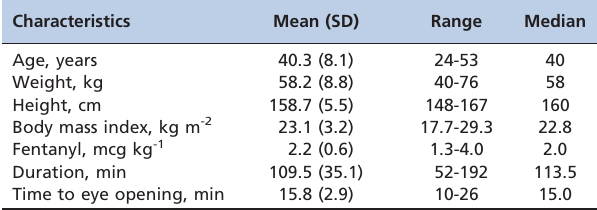
Table 1 - Patient characteristics (N = 32).